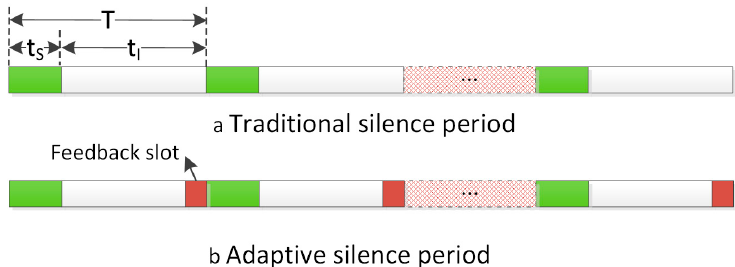
Figure 1. The slot division scheme of the SPM algorithm ( a ) Traditional silence period; ( b ) Adaptive silence period.